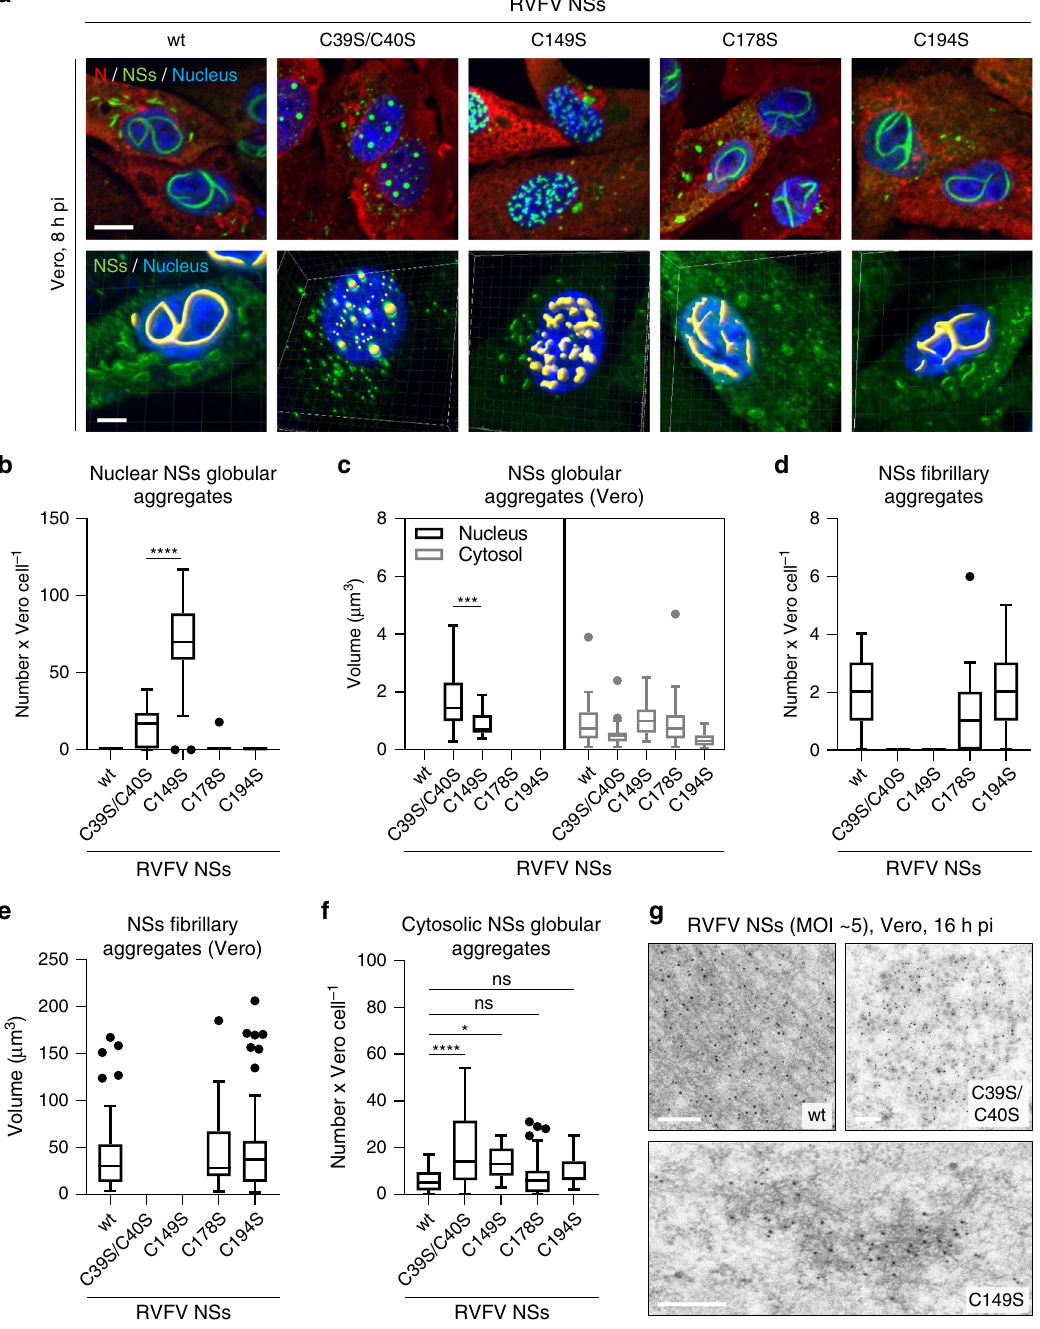
number and size of nuclear fi ber-bundles. The level of NSs protein did not reach a plateau value under our experimental conditions, though a threefold-to- fi vefold increase in protein abundance was measured between the lowest and highest MOIs (Fig. 4b and Supplementary Fig. 7A). Immuno fl uorescence con- focal microscopy of infected cells con fi rmed the positive corre- lation of NSs expression with MOIs (Fig. 4c). Note that NSs fi lamentous aggregates increased in thickness at the highest